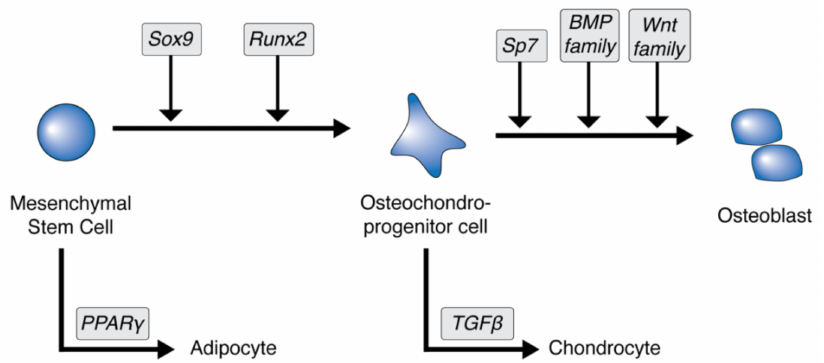
Figure 1. Mesenchymal stem cells differentiate into various cell types based on the expression of different transcription factors and protein families, highlighted in gray. Sox9: SRY-box transcrip- tion factor 9; Runx2: Runt-related transcription factor 2; Sp7: osterix; BMP: bone morphogenic protein; Wnt: wingless and int-1; PPAR γ : peroxisome proliferator-activated receptor gamma; TGF β : transforming growth